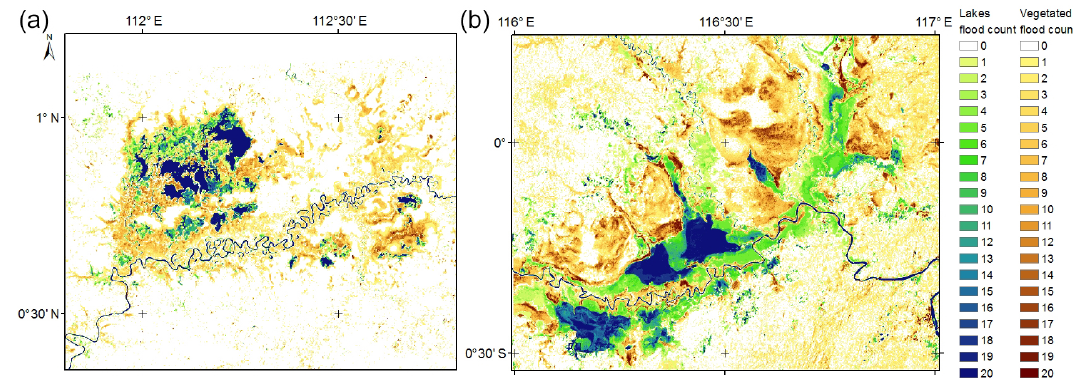
Figure 11. Inundation occurrence in the upper Kapuas (a) and Mahakam (b) lake area derived from 20 PALSAR images of 2007–2010 as open water (light green – dark blue) and flooding under vegetation (light – dark brown). Vertical legend on the right: Lake flood count in open water; vegetated flood count in flooding under vegetation.